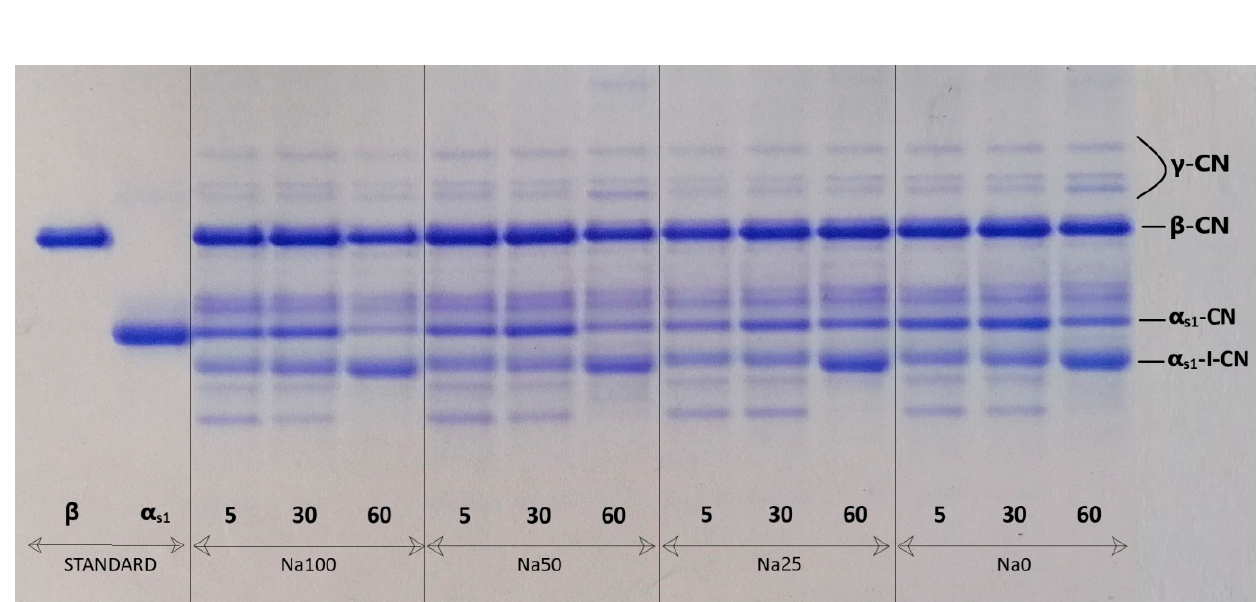
Figure 1. Urea polyacrylamide gel electrophoresis of Homoljski Sir with 100% NaCl and 0% KCl (Na100); 50% NaCl and 50% KCl (Na50); 25% NaCl and 75% KCl (Na25) and 0% NaCl and 100% KCl (Na0), at the 5th, 30th and 60th day of ripening. Other abbreviations are: CN—casein; STANDARD proteins: β —casein ( β ) and α —casein ( α